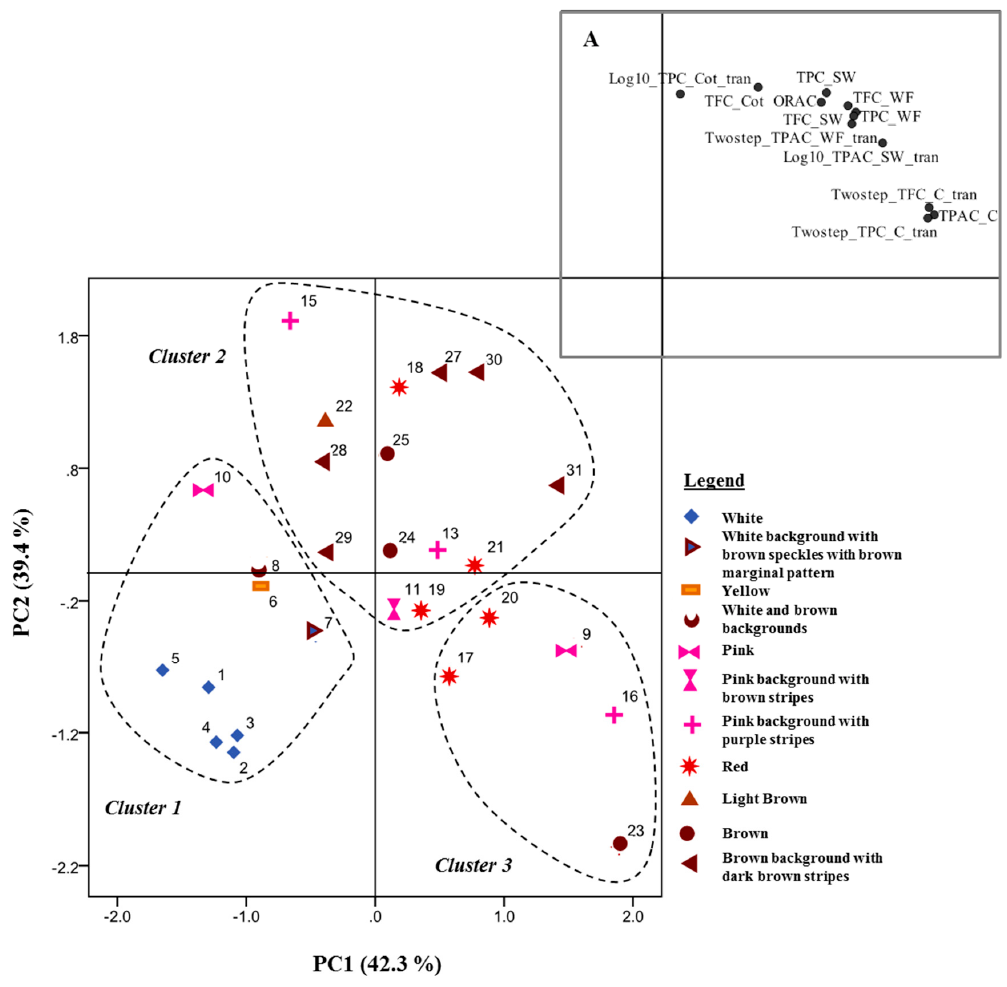
Figure 2. Projection of the Portuguese common bean varieties (n = 28) in a bi-dimensional space (Principal Component 1—PC1 and Principal Component 2—PC2). Color of samples was depicted and clusters highlighted. Explanation for subfigure A —Distribution of the parameters analyzed in the bidimensional space (TPCTotal Phenolic Content; TFC—Total Flavonoid Content; TPAC—Total Proanthocyanidin Content; ORAC—Oxygen Radical Absorbance Capacity; C—Coats; Cot—Cotyledons; SW—Soaking Water; WF—Whole Flour). To achieve normal distribution, the parameters TPC in